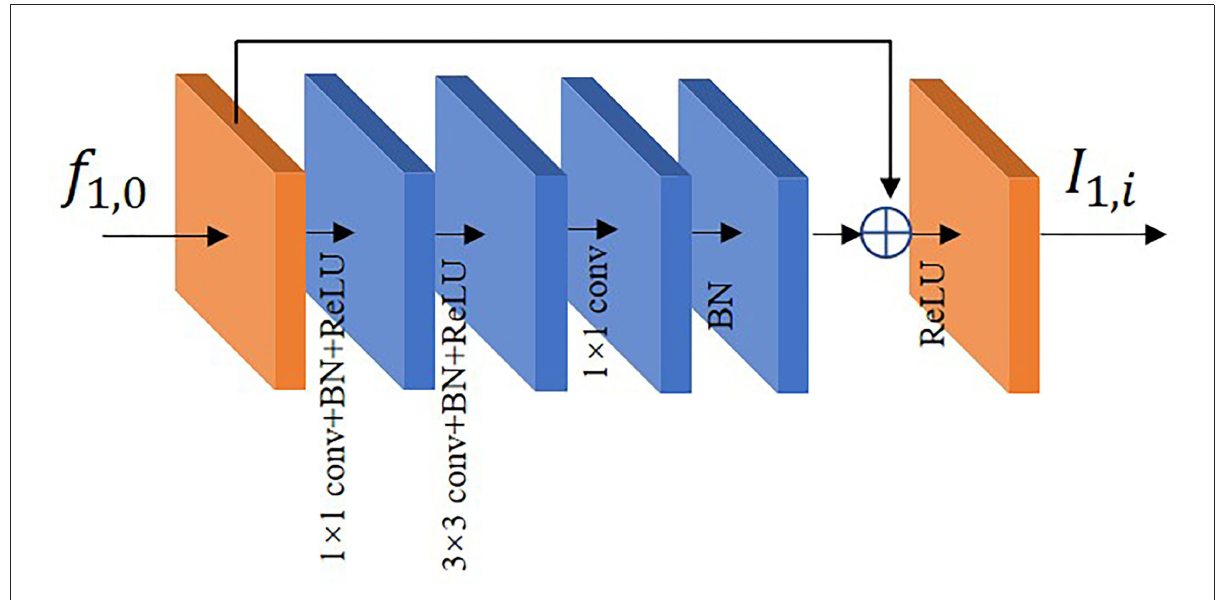
FIGURE5 The residual block